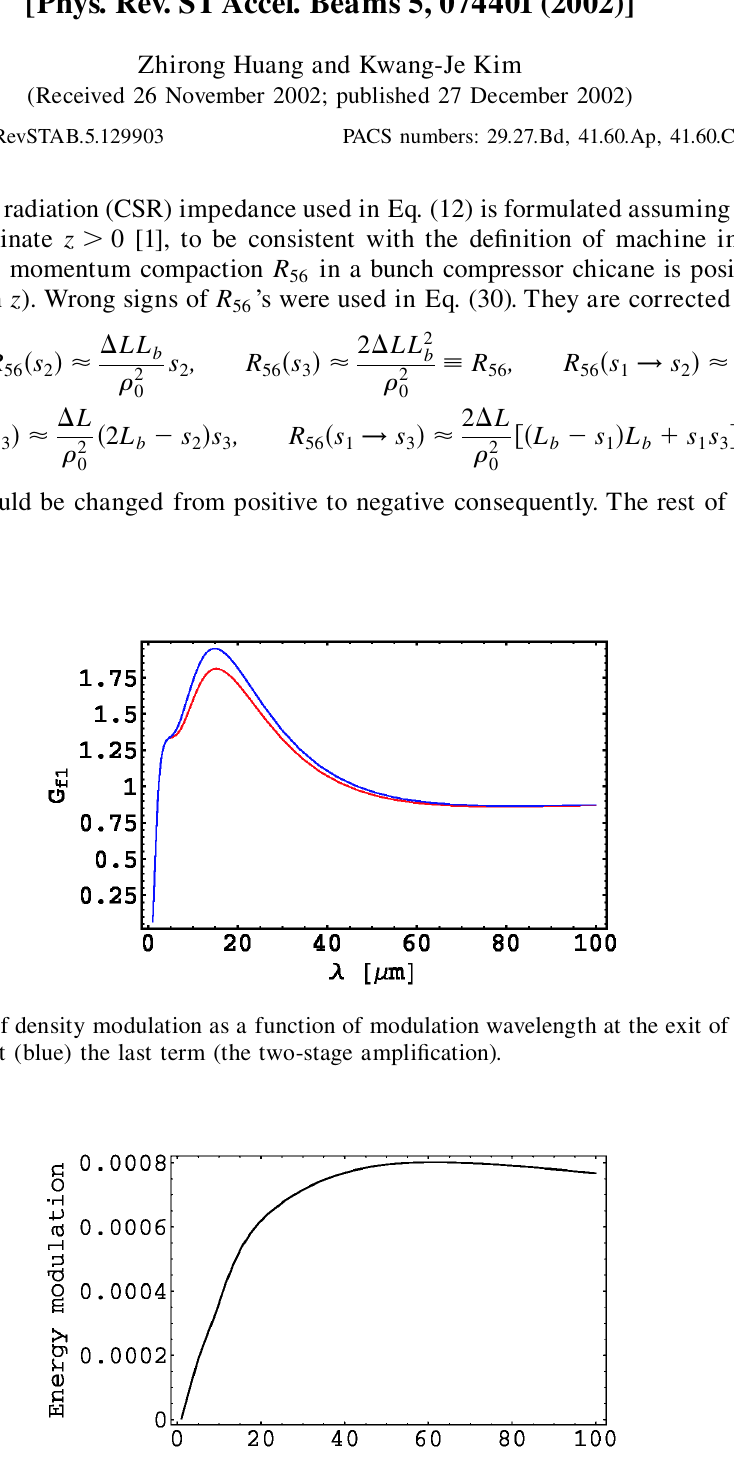
FIG. 2. Energy modulation amplitude j (cid:7) p of